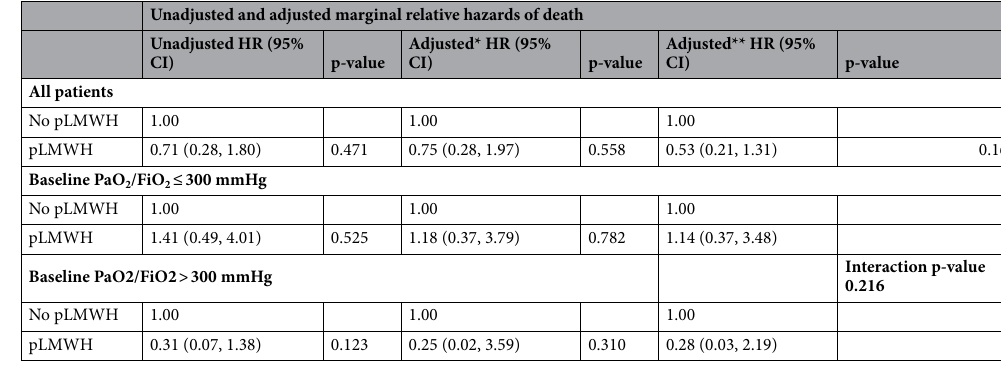
Table 3. Hazard Ratio of death in all population and according to PaO 2 /FiO 2 at admission. *Adjusted for time-fixed factors: age, gender, time from symptoms onset, comorbidities (cardiovascular diseases, hypertension, COPD/Asthma, diabetes), PaO 2 /FiO 2 at admission. **Adjusted for time-fixed and time varying factors: age, gender, time from symptoms onset, comorbidities (cardiovascular diseases, hypertension, COPD/ Asthma, diabetes), PaO 2 /FiO 2 at admission, time-varying use of immune-therapy, antiviral and steroids and censoring using IPW. pLMWH prophylactic dose of low molecular weight heparin.